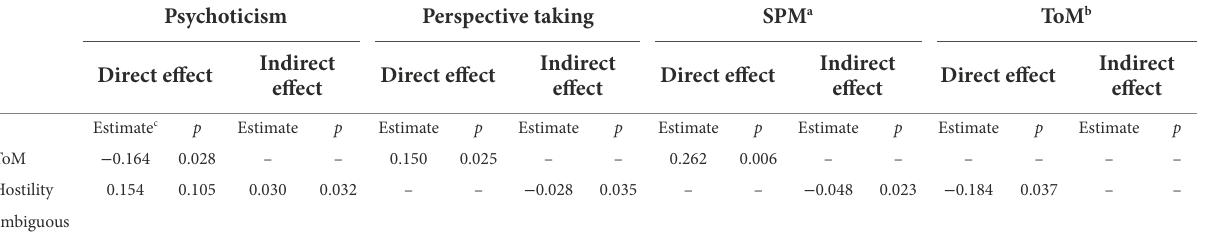
TABLE 3 Direct and indirect effect of variables (bootstrap =